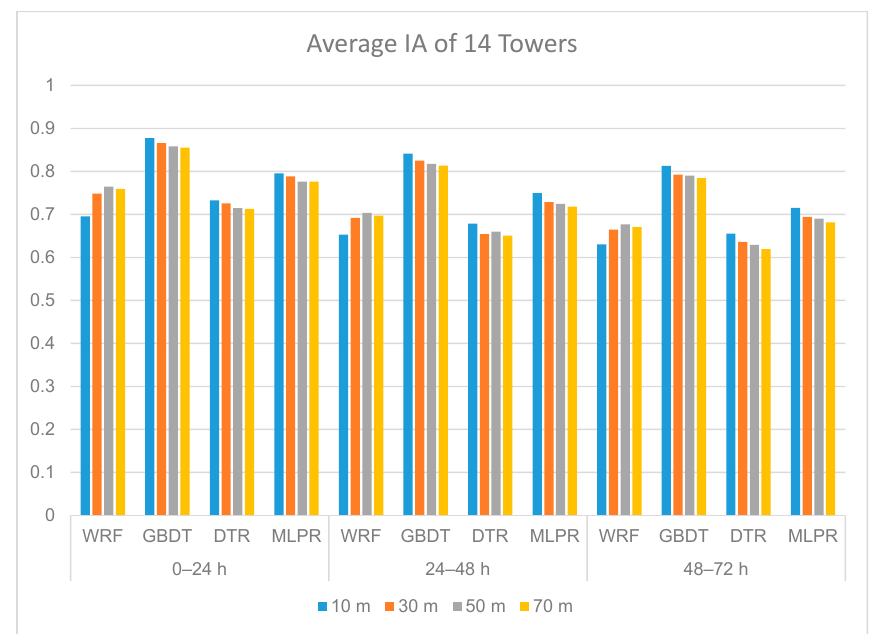
Figure 8. IAs of the WRF original output (WRF), GBDT output (GBDT), decision tree regression output (DTR), and multi-layer perceptron regression output (MLPR).